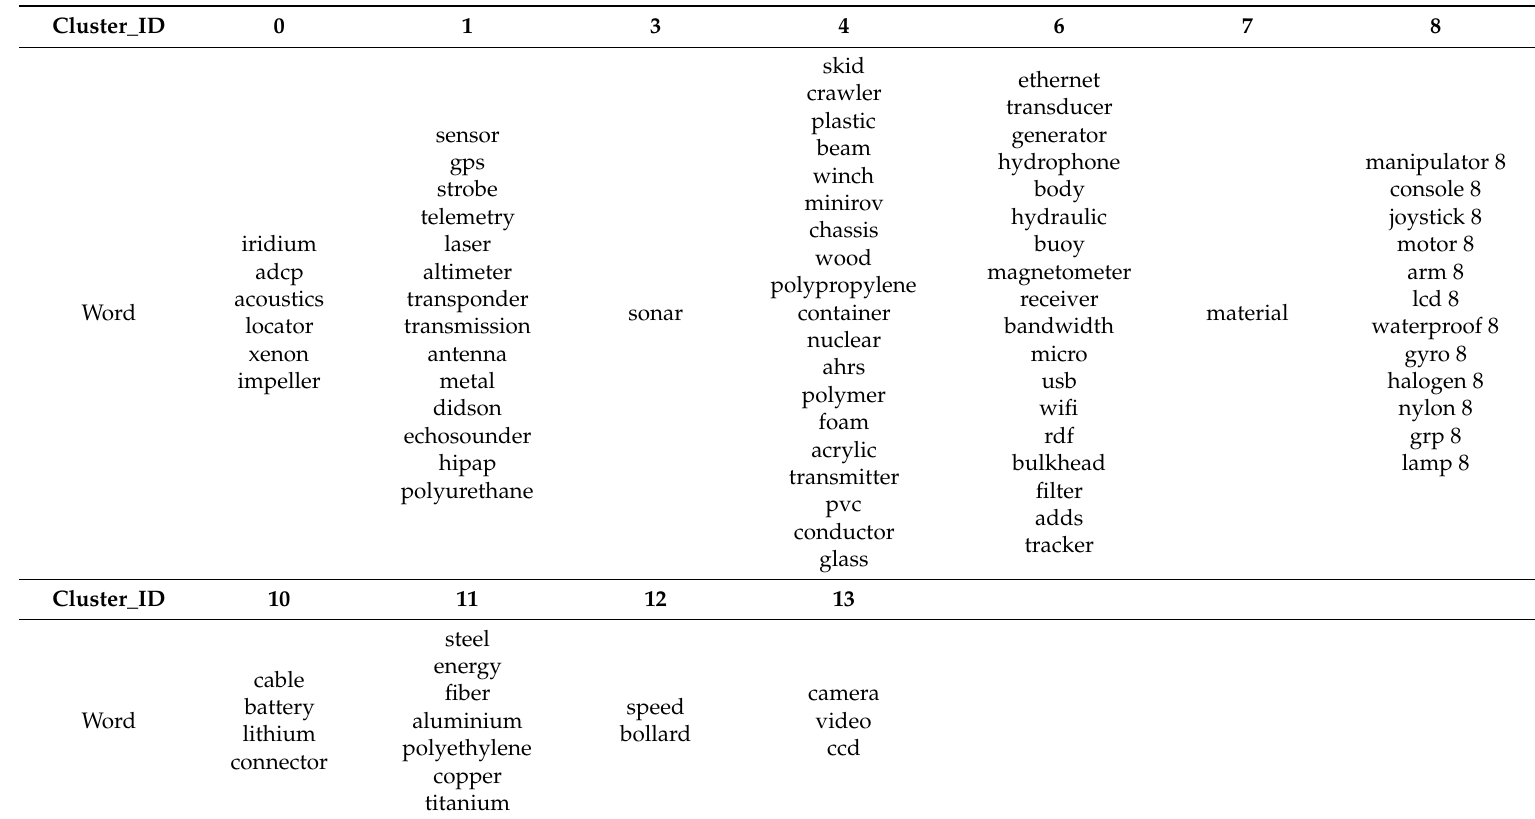
Table A2. K-means clustering results of product